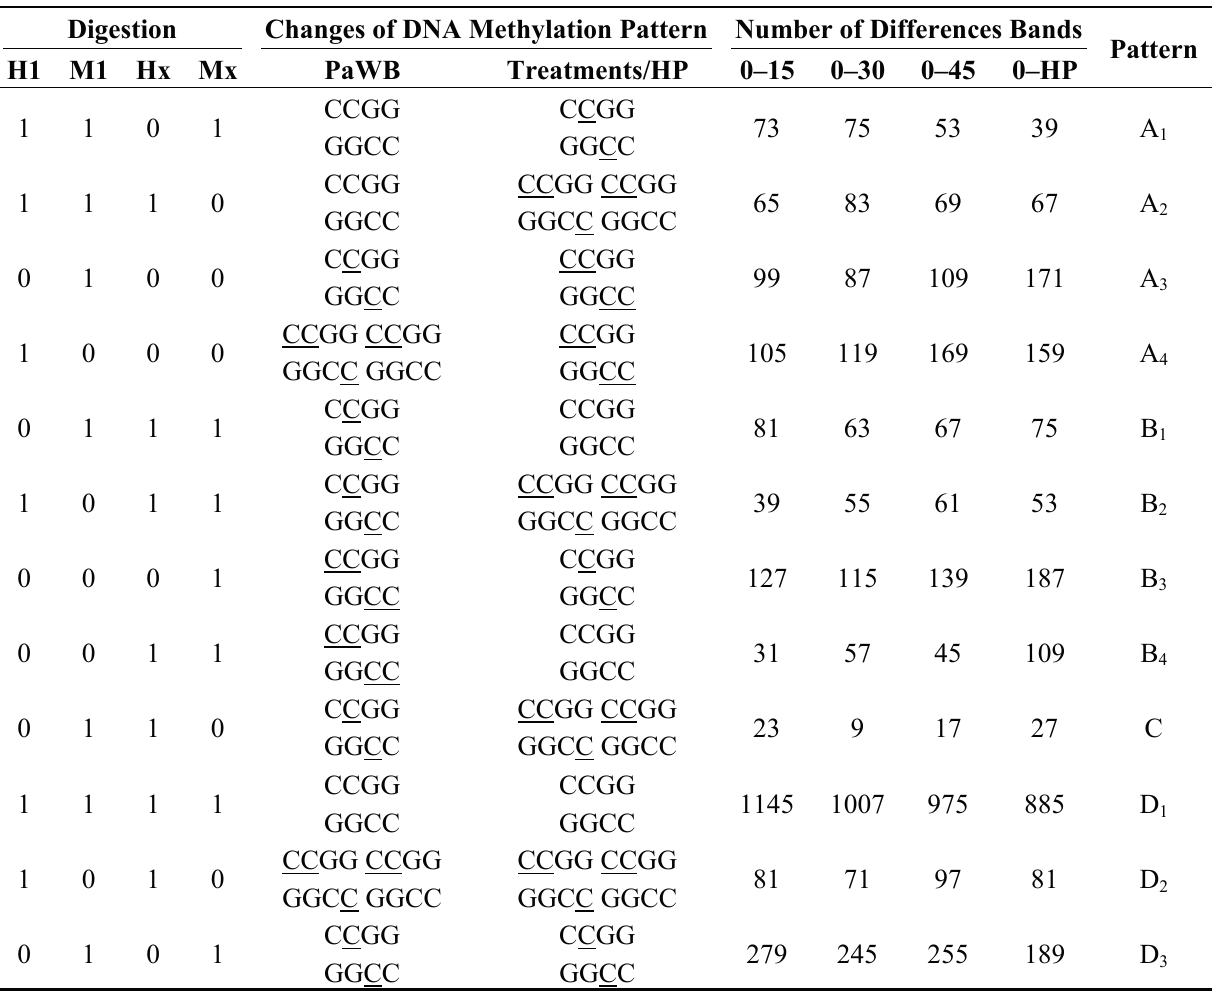
Table 2. Changes of DNA methylation pattern in MMS-treated PaWB plantlets. H1 and M1: band digested by H and M in PaWB plantlets. Hx and Mx: band digested by H and M in treatments or HP. The first column presents the status of the DNA methylation bands of PaWB and MMS-treated plantlets or healthy ones. The second column presents the status of the DNA methylation base of PaWB and MMS-treated plantlets or healthy ones in the genome sequence. 1: presence of a band. 0: absence of a band. C and CC: cytosine methylation. 0 – 15 : number of DNA methylation patterns between 15 mg·L − 1 MMS and PaWB plantlets; 0 – 30 : number of DNA methylation patterns between 30 mg·L − 1 MMS and PaWB plantlets; 0 – 45 : number of DNA methylation patterns between 45 mg·L − 1 MMS and PaWB plantlets; 0 – HP : number of DNA methylation patterns between healthy and PaWB